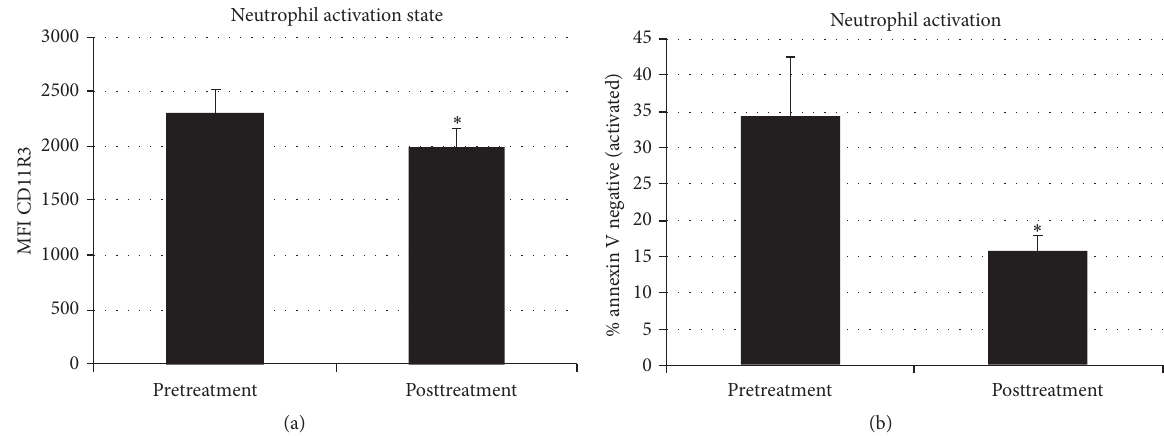
Figure 6: Systemic neutrophil activation can be evaluated by acute changes in CD11R3 expression and the percent circulating neutrophil population that is resistant to apoptosis in vitro . CD11R3 expression is increased acutely with neutrophil activation. With SCD exposure, CD11R3 expression decreased (a, 𝑛 = 6 ∗ , 𝑝 = 0.033 ). During the activated state neutrophil apoptosis is delayed. In these MetS animals, prior to SCD treatment, 34% of neutrophils are activated (resistant to apoptosis), while in healthy animals, less than 10% of circulating neutrophils are expected to be resistant to apoptosis. Analysis of apoptosis, before and after treatments, showed SCD Rx to move the neutrophil population to a less activated state, thus shifting toward na¨ıve percentages of neutrophils resistant to apoptosis (b, 𝑛 = 9 , 𝑝 = 0.023 ). ∗ For CD11R3 expression, only 2 of the 3 SCD Rx courses with three 6-hour treatments each were included in the analysis ( 𝑛 = 6 ) due to an unanticipated analytic procedural complication.